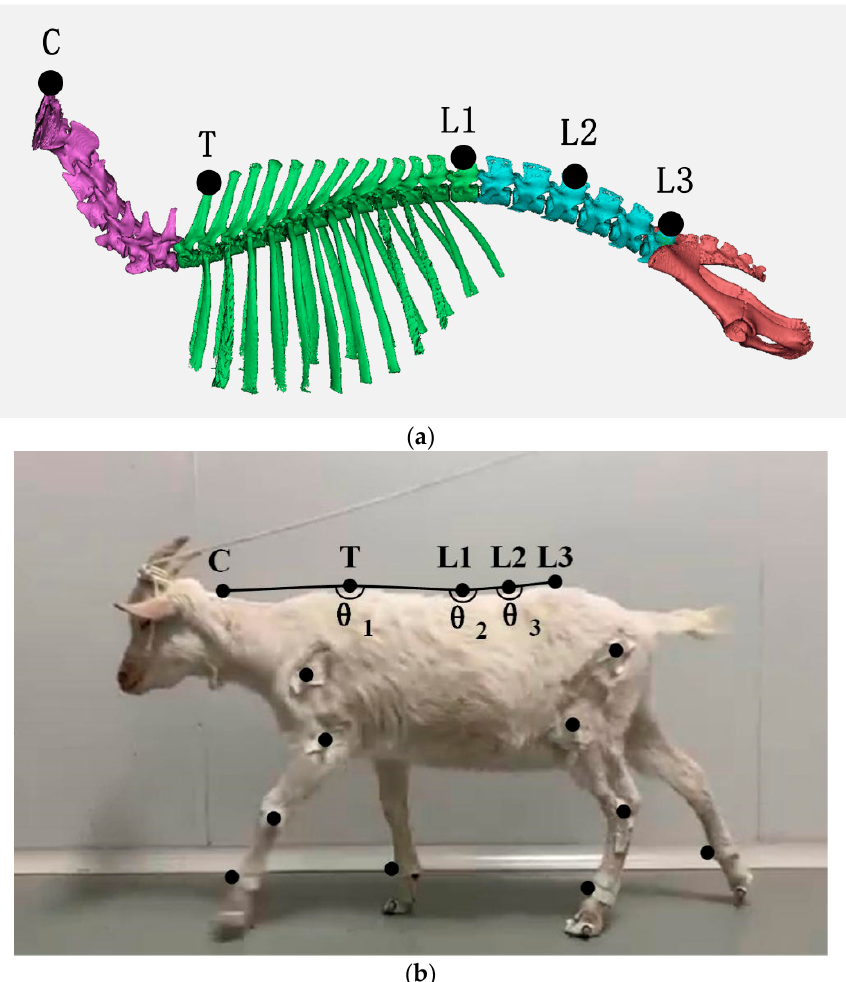
Figure 1. Placement map of reflective balls pasted on the spine: ( a ) schematic representation of the position of spinal markers; ( b ) location map of spinal markers for the test subject.